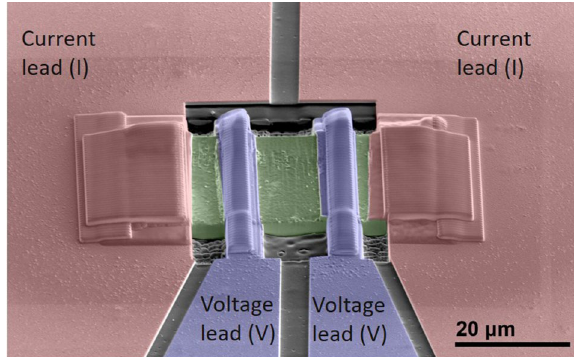
Figure 1. SEM image of Ta-Hf-doped Nb 3 Sn microbridge. False-coloured SEM image of a thin lamella (green) extracted by focused ion beam (FIB) from a Ta-Hf-doped Nb 3 Sn sample. The FIB’ed lamella is mounted on